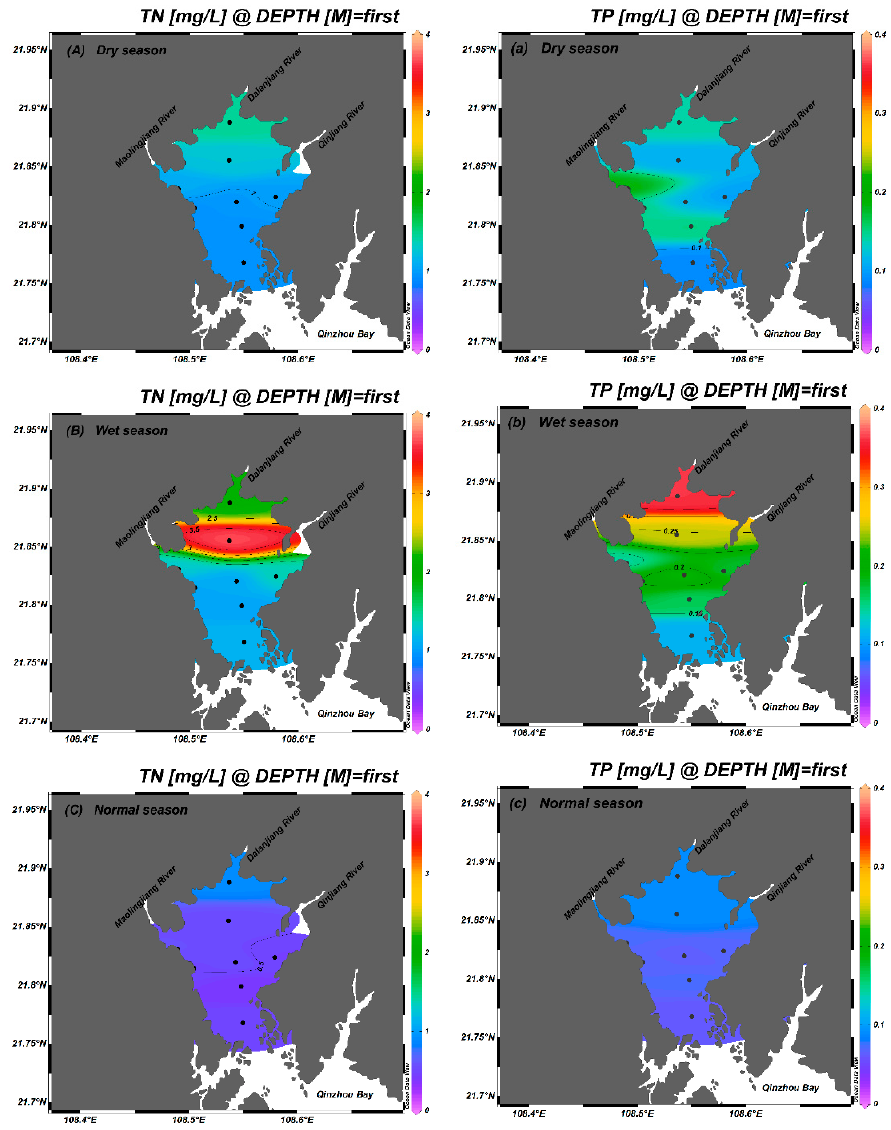
Figure 4. Spatiotemporal distributions of TN and TP in the Maowei Sea in dry, wet and normal seasons. Table 1. Seasonal mean and range of TN, TDN, DIN, TP, TDP and DIP concentrations in the MWS (mg/L).